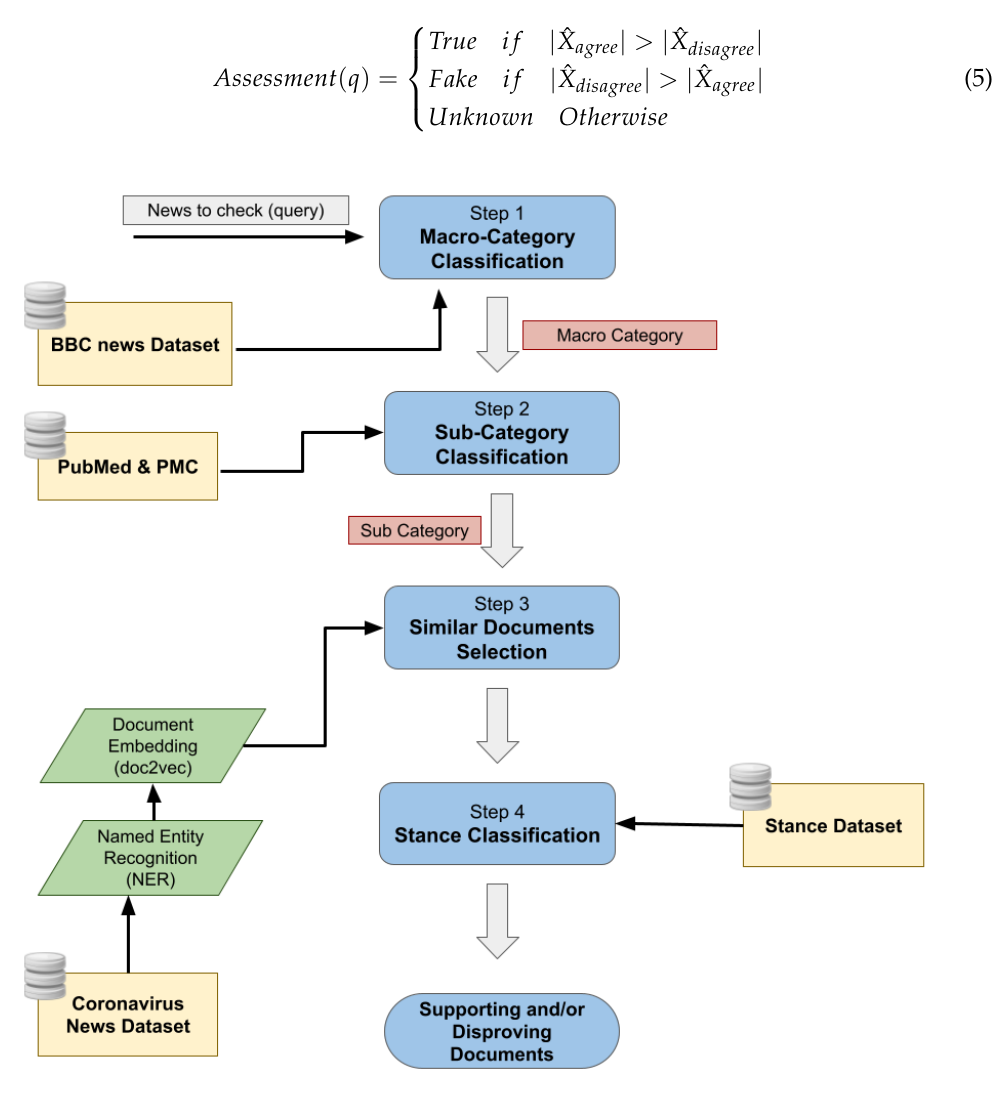
Figure 1. Fake news detection system